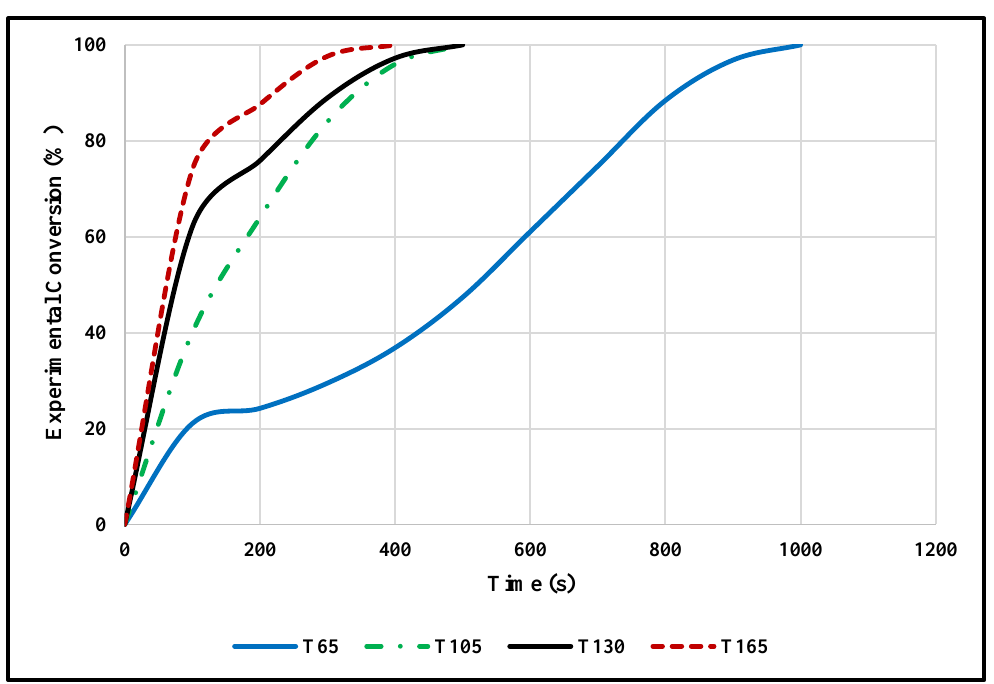
Processes 2020 , 8 , x FOR PEER REVIEW Figure 4. Conversion profiles for different initial vessel temperatures. Figure 4. Conversion profiles for di ff erent initial vessel temperatures.